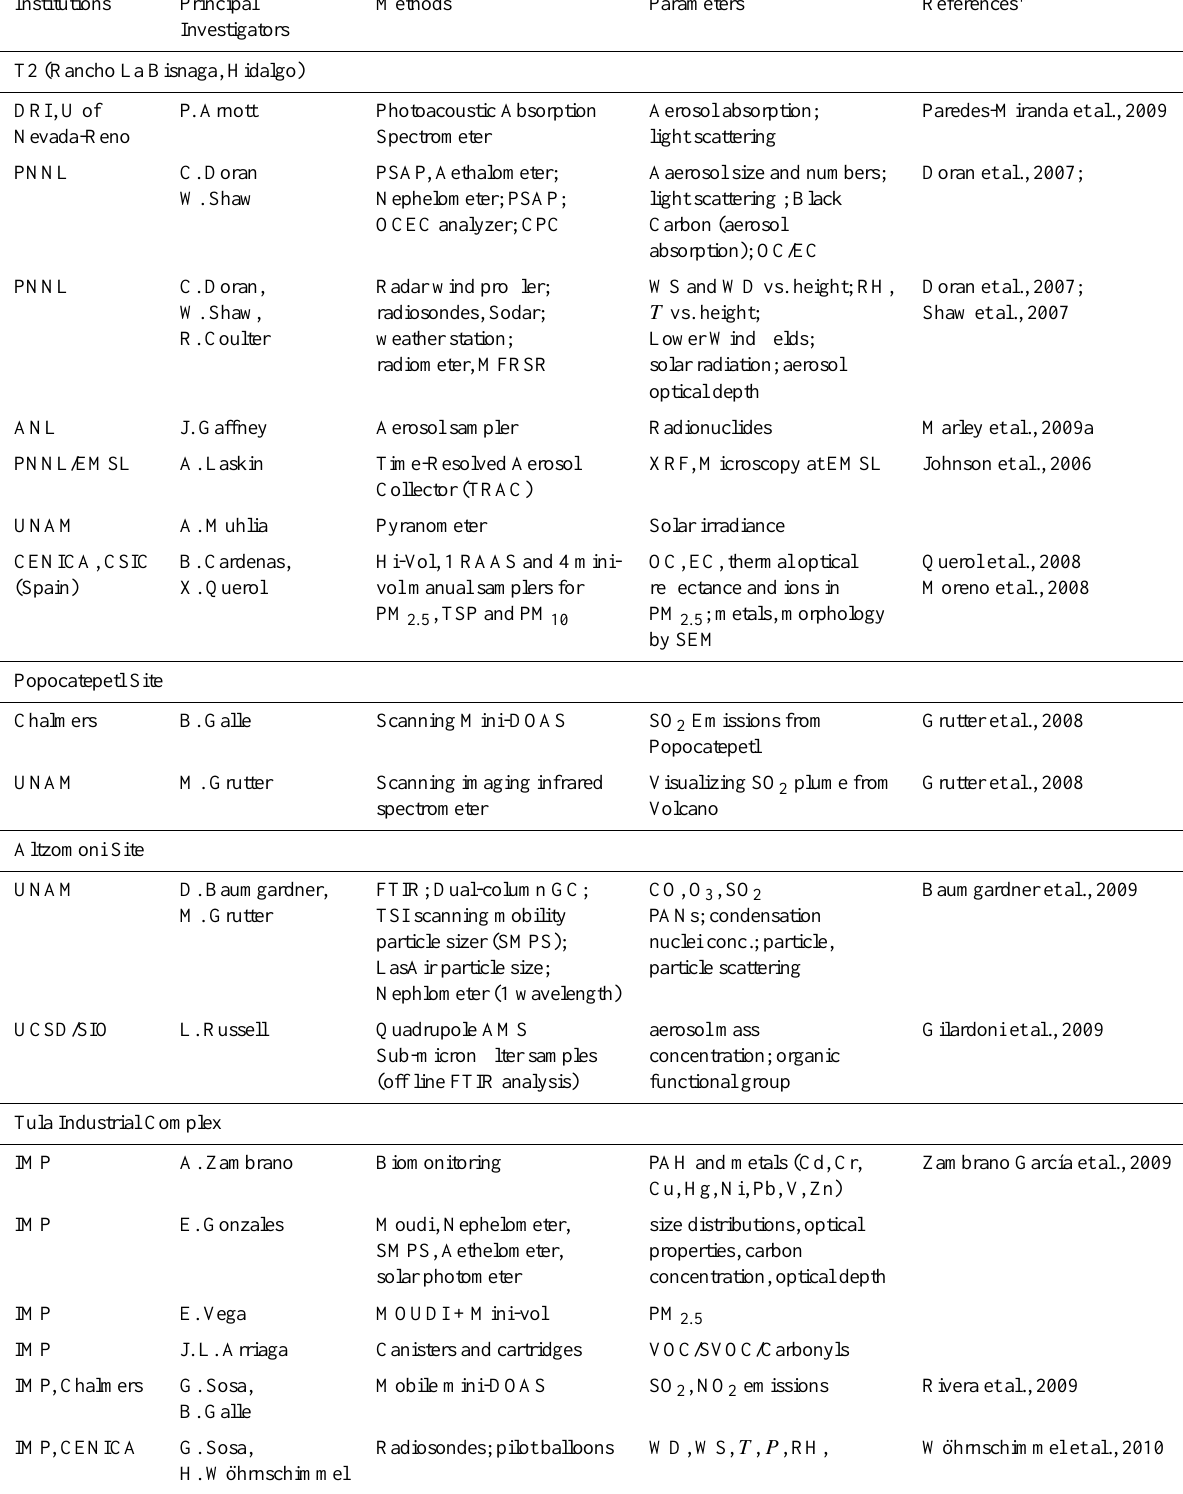
Table 3. List of participating institutions and instruments deployed at T2 and other sites